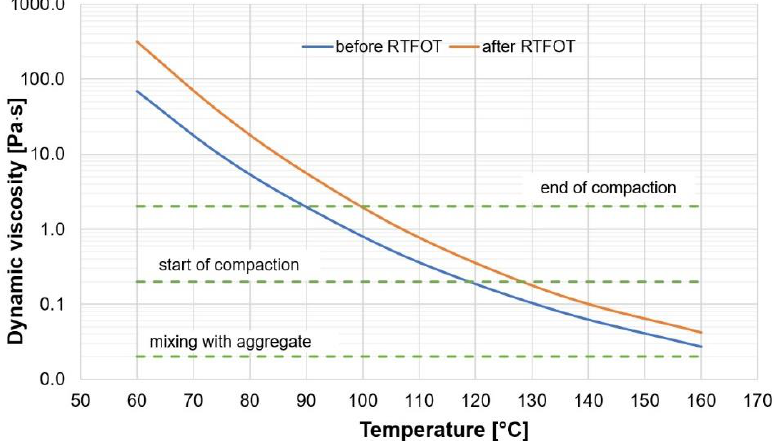
Figure 1. Viscosity of the 35/50 bitumen vs. temperature (before and after RTFOT aging).